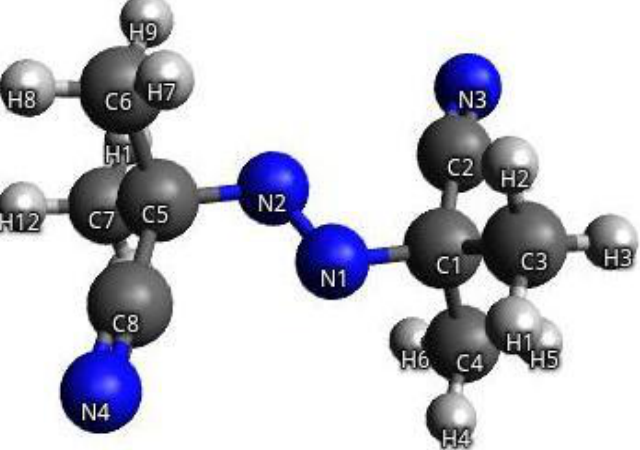
Figure 1. The AIBN structure at the minimum energy.